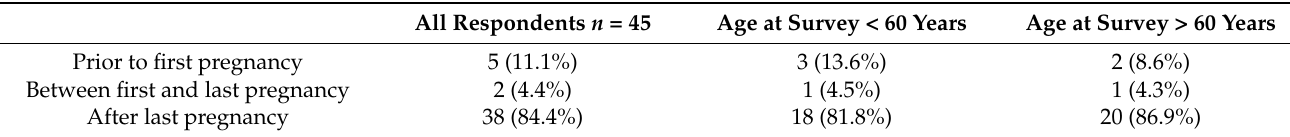
Table 1. Timing of HHT diagnosis relative to pregnancy ( n =